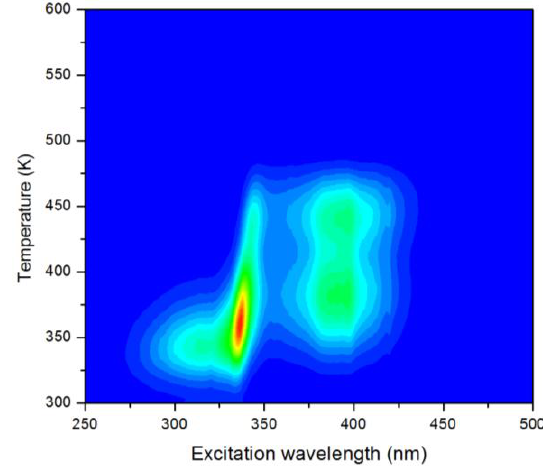
Figure 6. TL-excitation mapping: the TL measurement is repeated for different excitation wavelengths, showing which wavelengths are suited for trap filling. An example is shown for Cu + -emission in ZnS (presented earlier in [258]). It can be seen that different kinds of traps are being filled by short (<340 nm) and longer (>340 nm) wavelengths, where 340 nm corresponds to the band gap of the ZnS host